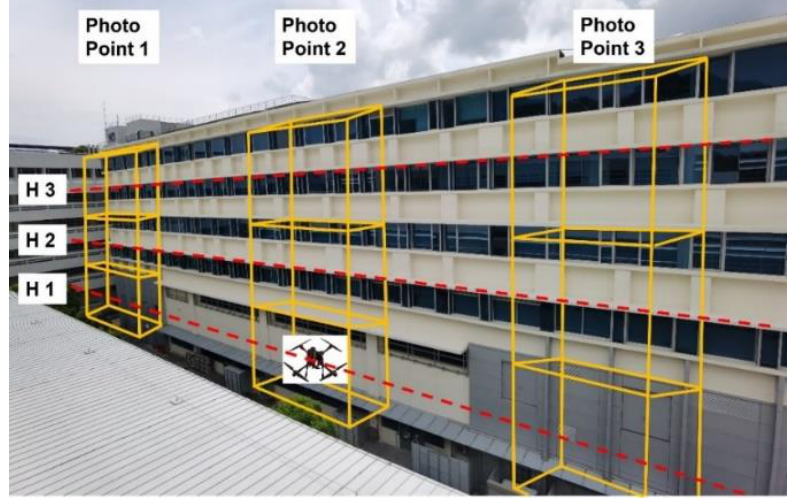
Figure 8. Illustration of Different Points at Three Altitudes for the N3.1 Location.